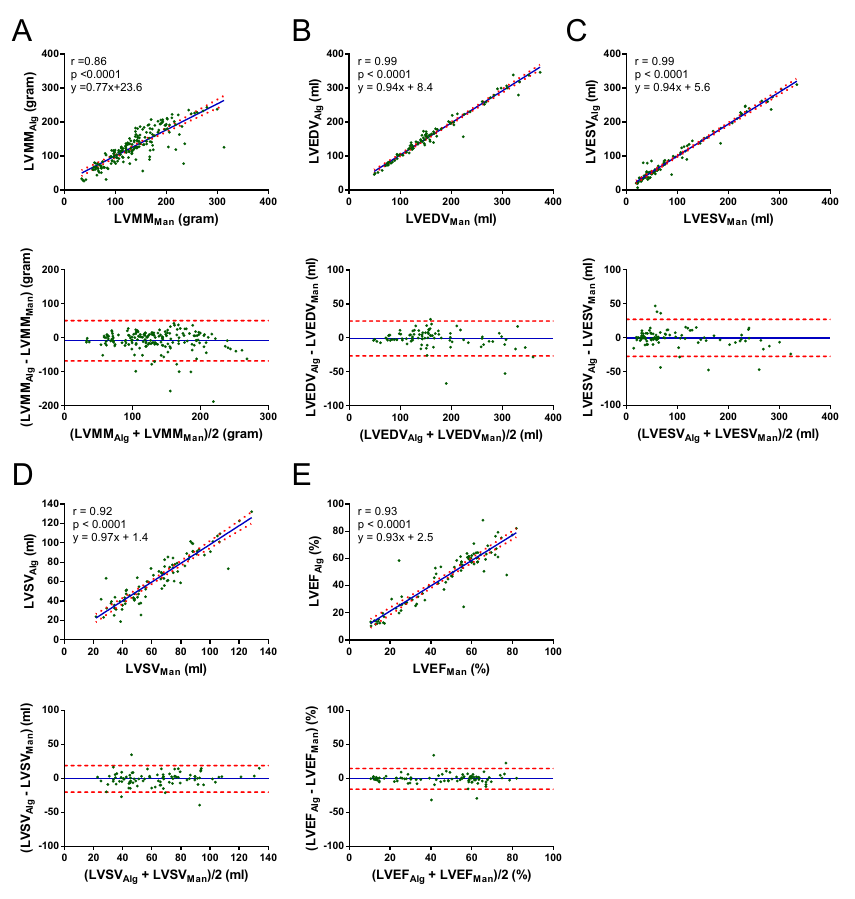
Combined. vs. DeepLab vs. Manual Manual